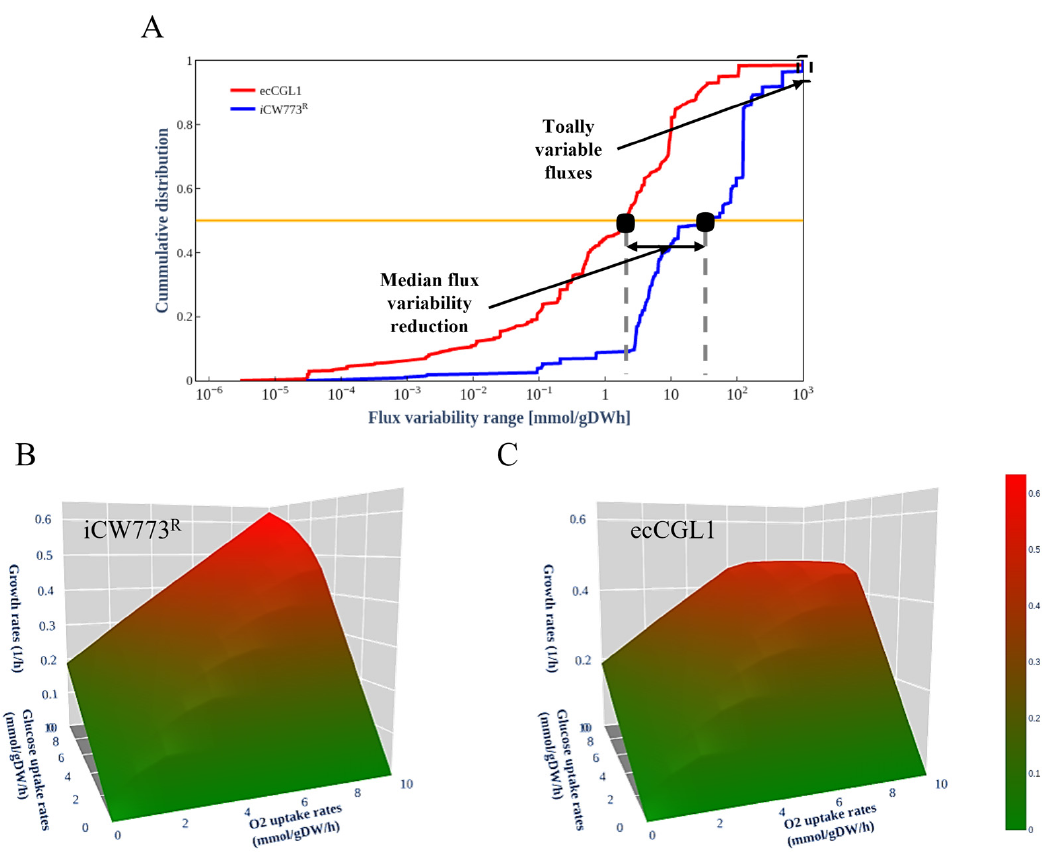
Figure 3. The solution space of iCW773 R and ecCGL1. ( A ) Cumulative distribution of flux variability of ecCGL1 and iCW773 R at high growth rates. Growth rates at various glucose and oxygen uptake rates were simulated using iCW773 R ( B ) and ecCGL1 ( C ).